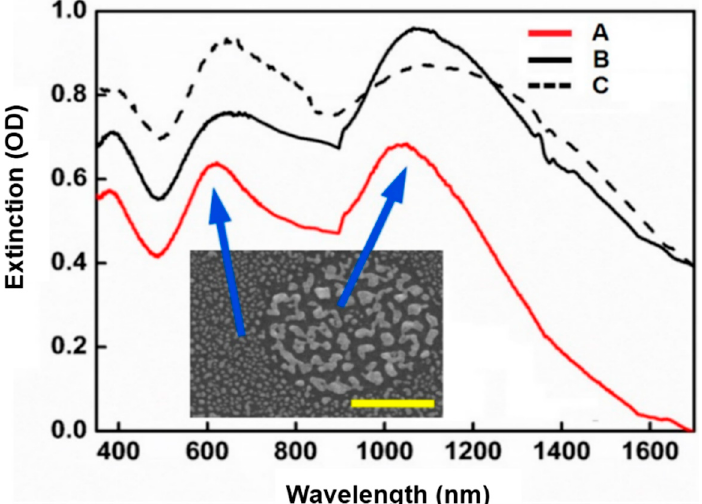
Figure 7. Optical extinction spectra measured on Samples A (red), B (black, solid), and C (black, dashed). Inset: a local SEM image on Sample A with the scale bar denoting 1 μ m.